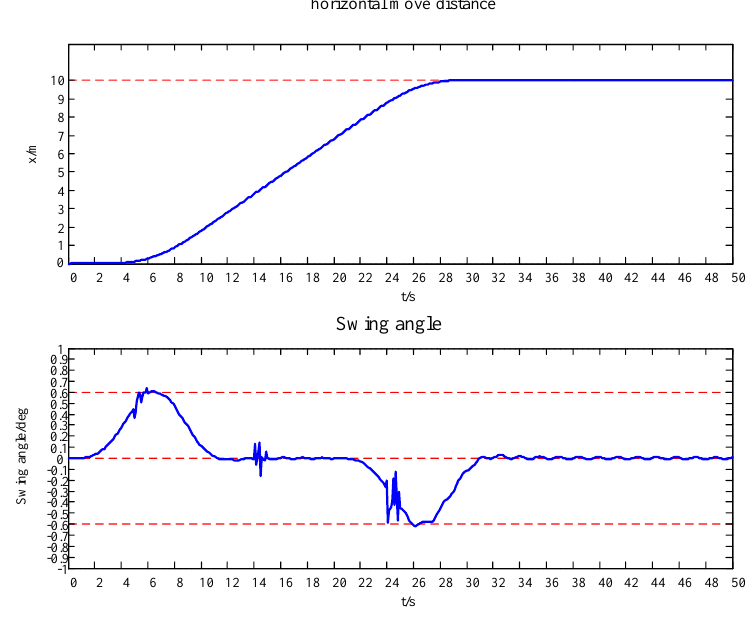
Figure 7. Result of simulation 3.